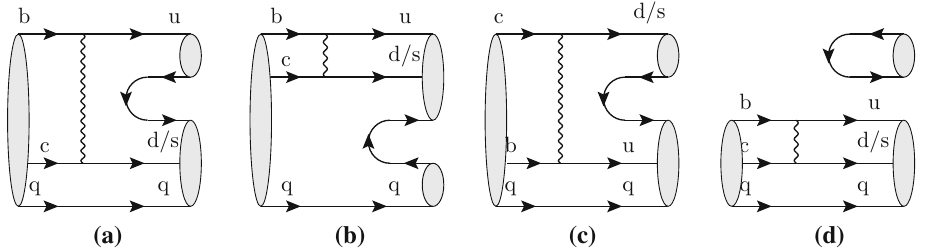
diagrams will contribute to an SU ( 3 ) triplet, and have been contained in the b → q 1 ¯ q 2 q 3 cases. So that will not be covered again